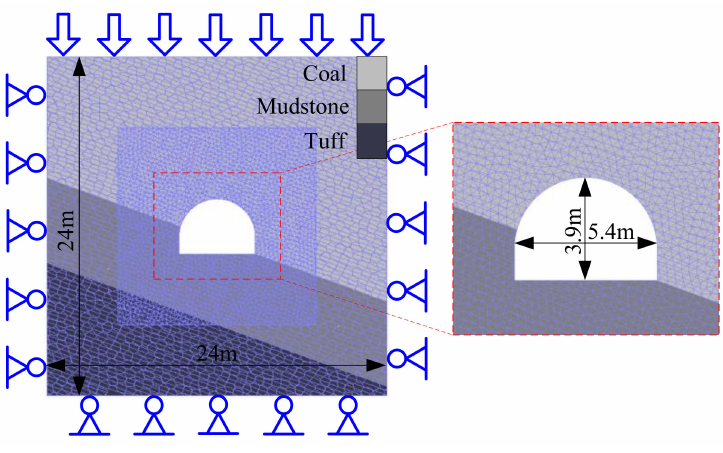
Figure 8. Numerical model for the coal